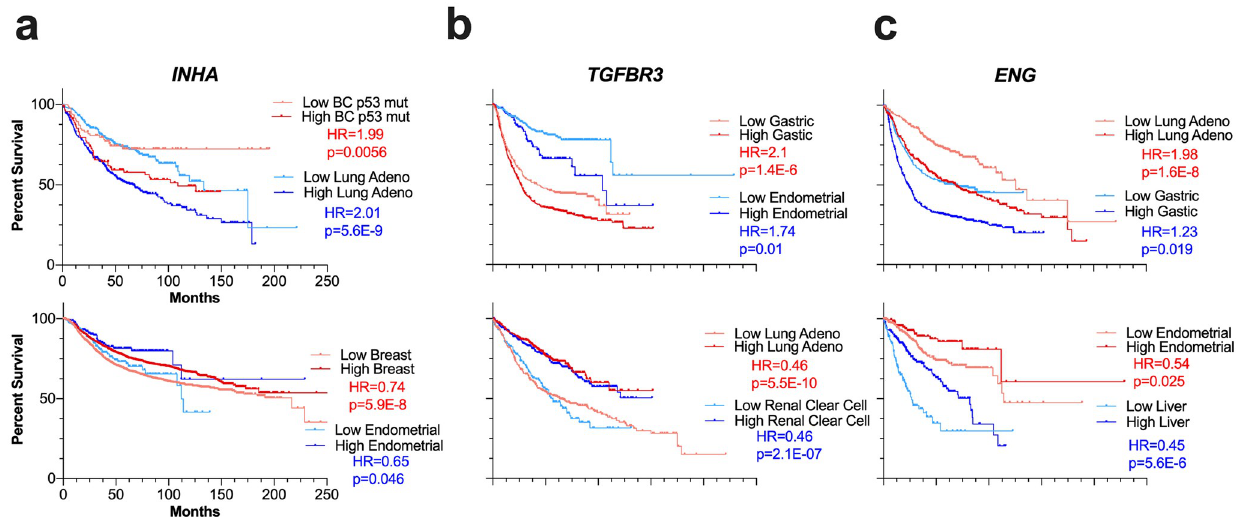
Fig 3. Representative Kaplan Meier curves for INHA , TGFBR3 , and ENG . Event-free survival in indicated cancers using median to separate expression (lighter shade indicates bottom patients expressing bottom 50% and darker shade top 50%). Survival curves represent OS for all cancers except breast cancer (RFS) and ovarian cancer (PFS). Top plots show cancer types where the gene is a negative predictor of survival, and bottom plots show cancer types where the gene is a negative predictor.